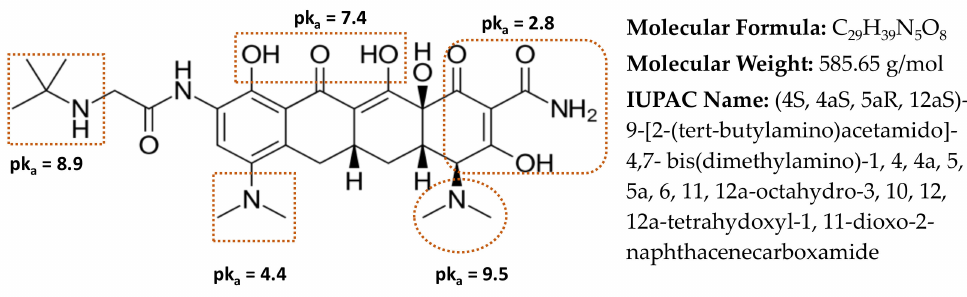
Figure 1. Chemical structure of tigecycline (TIGC) together with the relevant data from